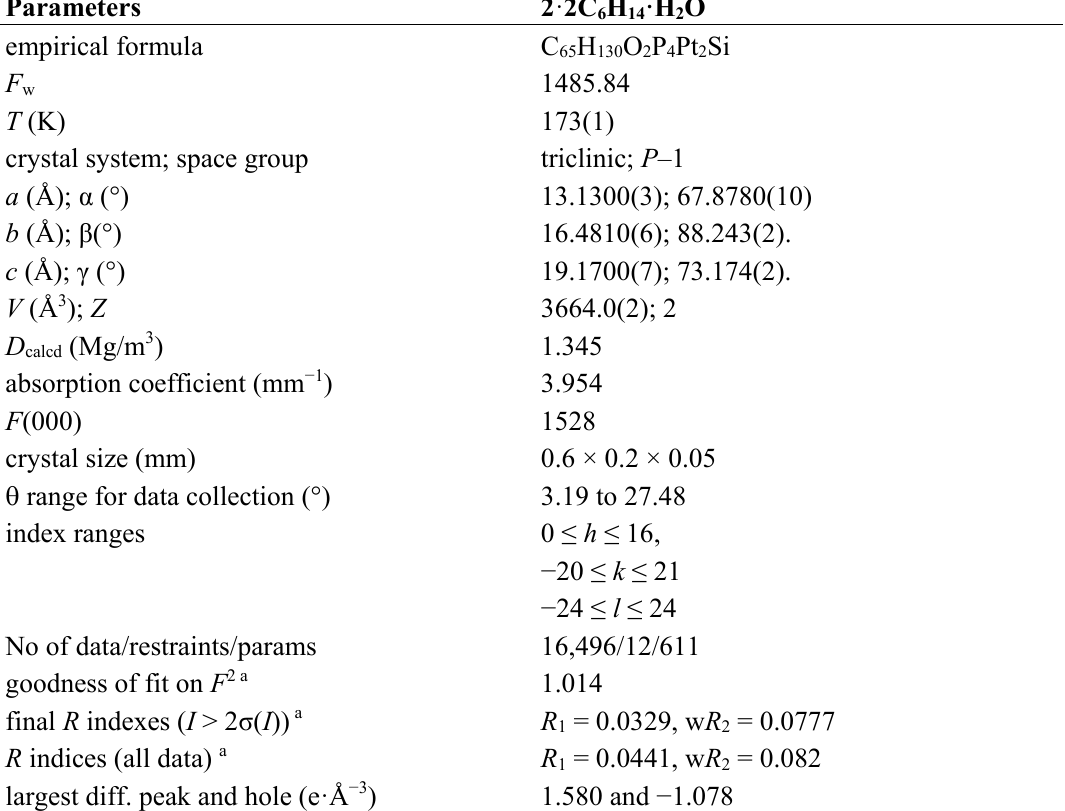
Table 2. Selected crystal data and structure refinement details for 2 ·2C 6 H 14 ·H 2 O.